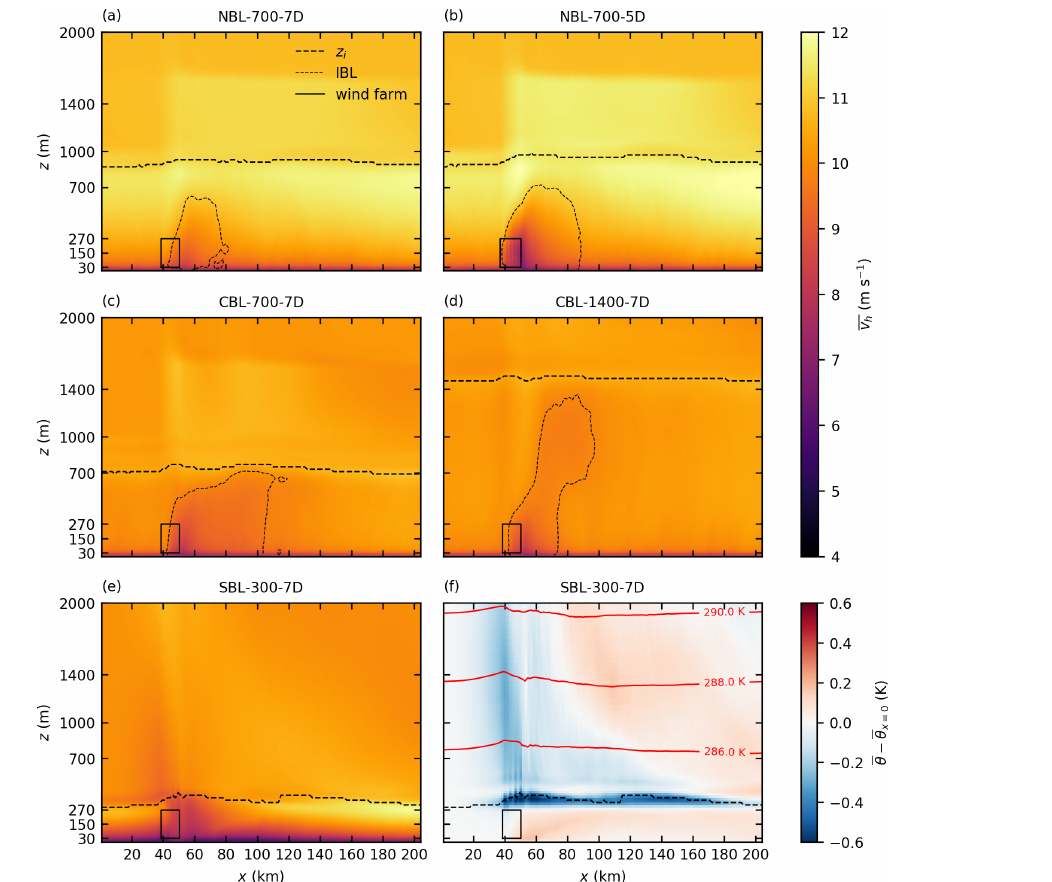
Figure 8. Vertical cross sections at y = 50km of wind speed v h for all cases (a–e) and potential temperature deviation relative to the inflow temperature for the case SBL-300-7D (f) . Also shown are the inversion layer height z i (maximum vertical temperature gradient), the internal boundary layer IBL (97% of inflow wind speed) and the extent of the wind farm